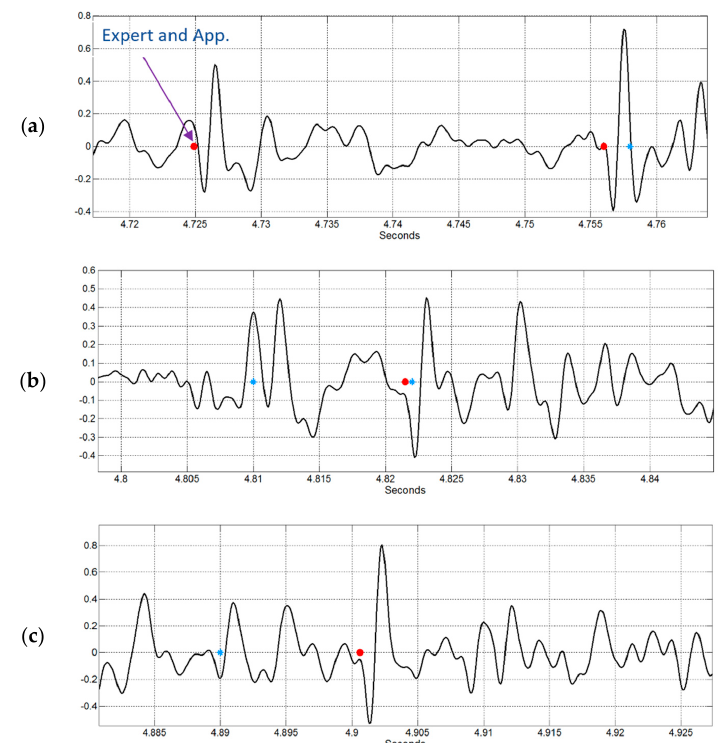
Figure 11. Examples of crackle detection performed by pneumologists (blue dots) and the developed smartphone application (red dots) in real acquired data from DIP patients. ( a ) Example of matching detection between pneumologists and the app. ( b ) Example of an extra detection provided by pneumologists but not by the app. ( c ) Example of an extra detection provided by pneumologists but not by the app and of a missing detection by pneumologists but detected by the app.